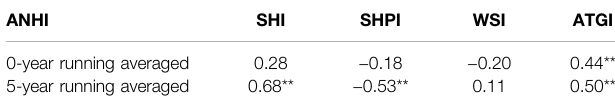
TABLE 3 | Correlation coef fi cients between ANHI and each meteorological index. ANHI SHI SHPI WSI